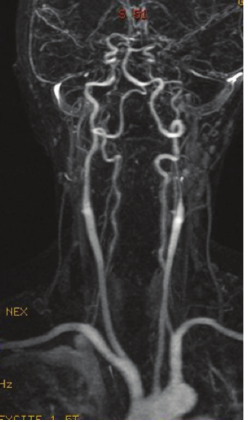
Figure 2: Supra-aortic MRA shows narrowing of the left internal carotid artery.